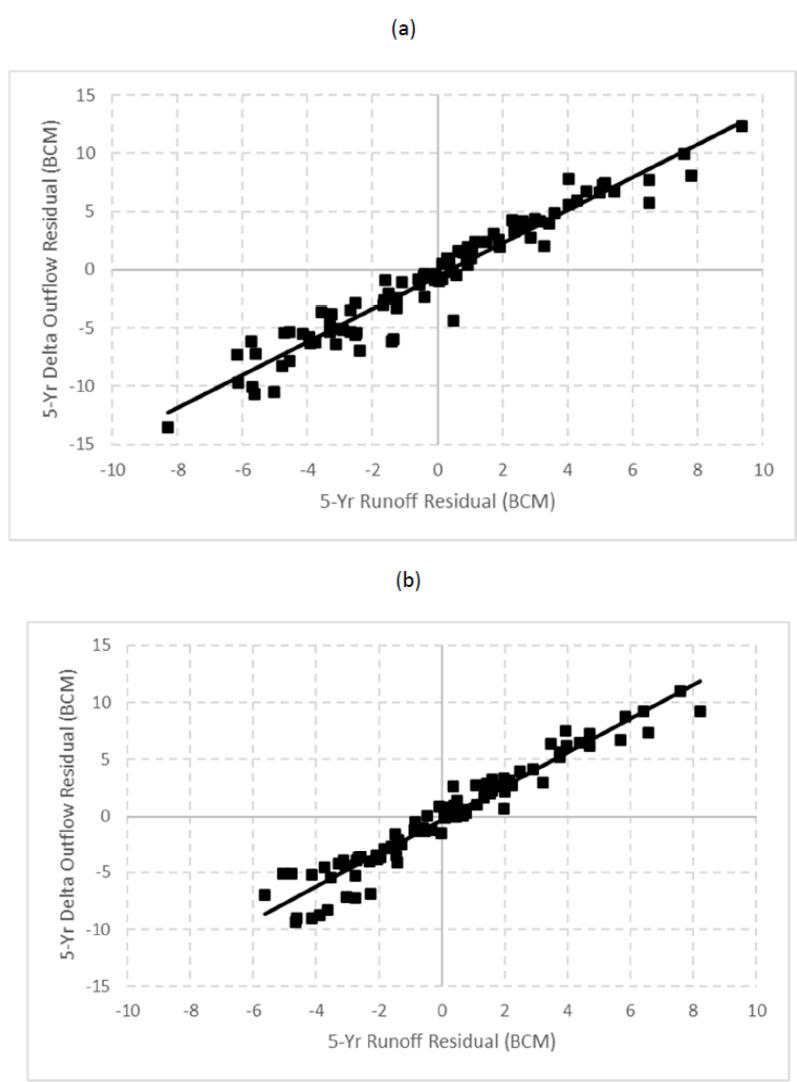
Figure 9. Relationship between reconstructed annual delta outflow residuals and reconstructed central valley runoff residuals for the contemporary period. Residuals are presented as 5-yr center weighted averages. The long record (WYs 1912–2008) and short record (WYs 1912–2001) relationships are shown in ( a ) and ( b ), respectively.